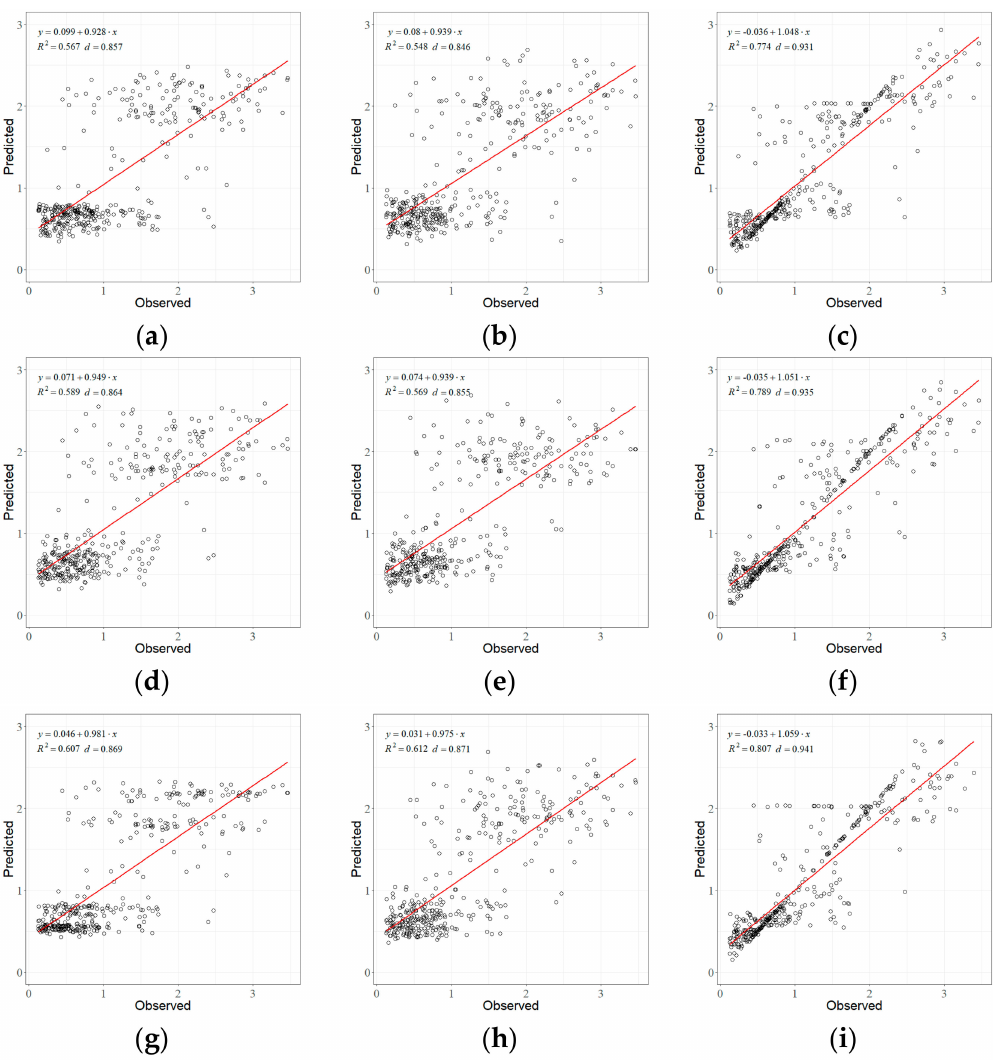
Figure 6. Scatter plots of the predicted LAI against the observed LAI in Ganzhou using three models and three set inputs of the selected spectral variables: ( a ) Input 1 and traditional kNN; ( b ) input 1 and RF; ( c ) input 1 and modified kNN; ( d ) input 2 and traditional kNN; ( e ) input 2 and RF; ( f ) input 2 and modified kNN; ( g ) input 3 and traditional kNN; ( h ) input 3 and RF; and ( i ) input 3 and modified kNN.